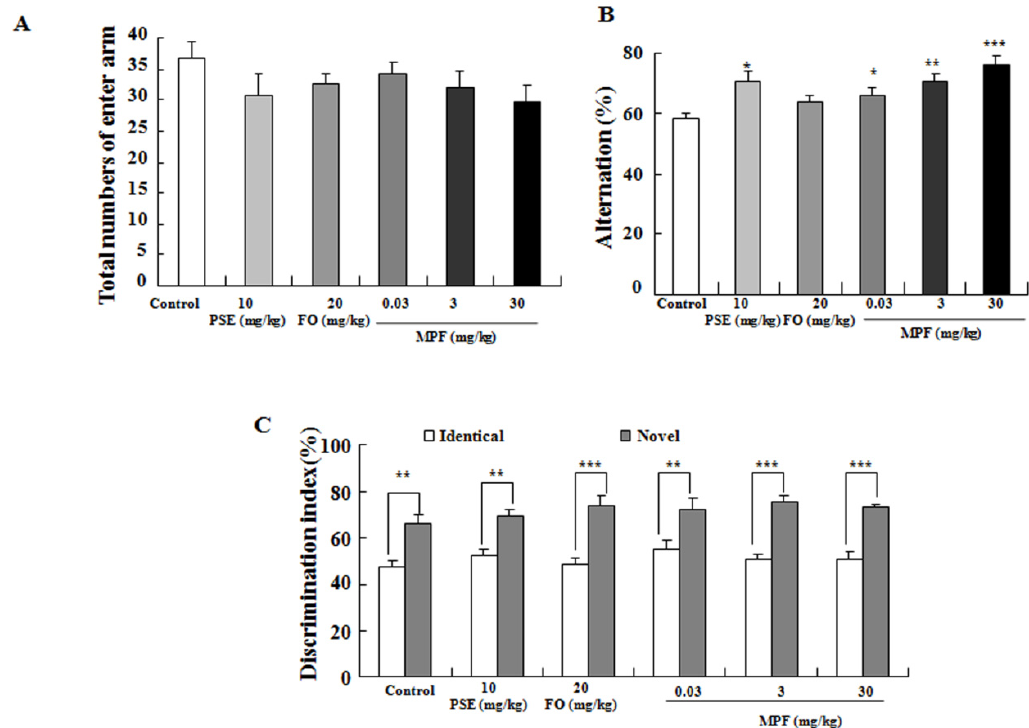
Figure 2. Effects of PSE, FO, and MPF on the learning and memory of mice in vivo . ( A ) changes in total numbers of enter arm; ( B ) alternation in the Y ‐ maze test after treating PSE, FO and MPF; ( C ) change in cognitive index in the novel object recognition test after treating PSE, FO and MPF. Y maze and NOR tests were performed after sample administration for five weeks. Each value represents the mean ± SEM of eight or seven mice. * , ** and *** indicate significant difference relative to the control group at the same time point at p < 0.05, p < 0.01 and p < 0.001, respectively.